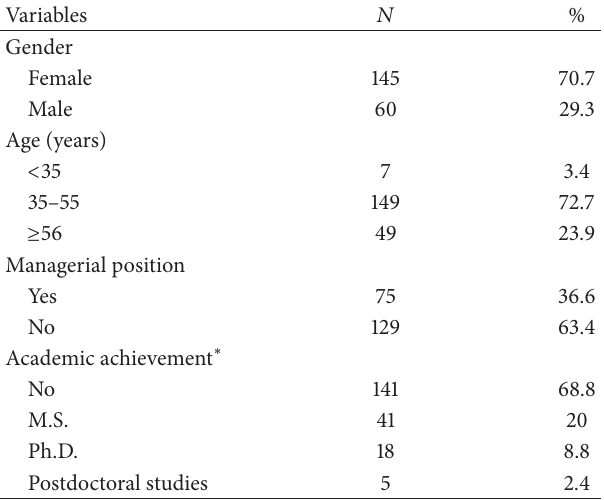
Table 1: Study population sociodemographic and work-related